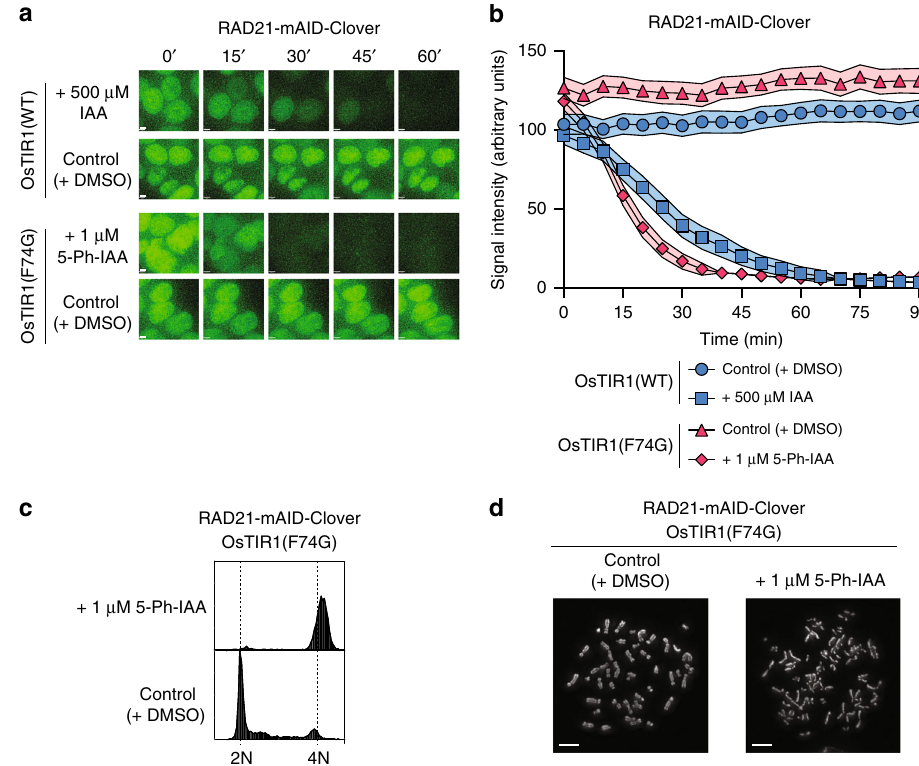
Fig. 3 Comparison of endogenous RAD21 depletion by the AID and AID2 systems. a RAD21-mAC cells expressing OsTIR1(WT or F74G) were treated with the indicated ligand and time-course images were taken. We repeated each experiment at least twice and obtained similar results. Scale bars show 3.2 µ m. b A graph was drawn using the quanti fi ed nuclear Clover signal from 60 cells. Data are presented as mean values of 95% con fi dence interval ( n = 60 cells examined). c RAD21-mAC cells expressing OsTIR1(F74G) were treated with 1 µ M 5-Ph-IAA for 24 h before fl ow cytometric analysis. d Mitotic chromosomes were assessed by a spread after treating RAD21-mAC cells expressing OsTIR1(F74G) with 1 µ M 5-Ph-IAA for 2 h. We repeated this twice and obtained consistent results. Scale bar shows 5.4 µ